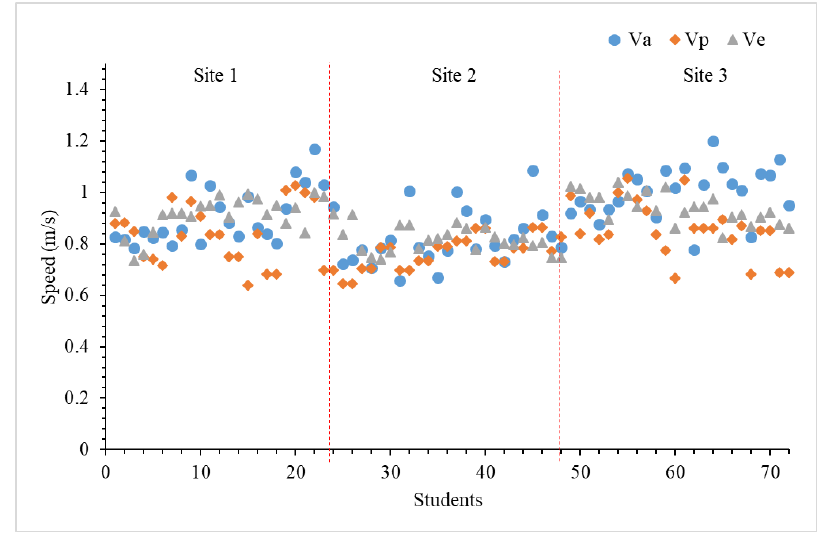
Figure 7. The speed of each student walking through 12 steps for ESs.